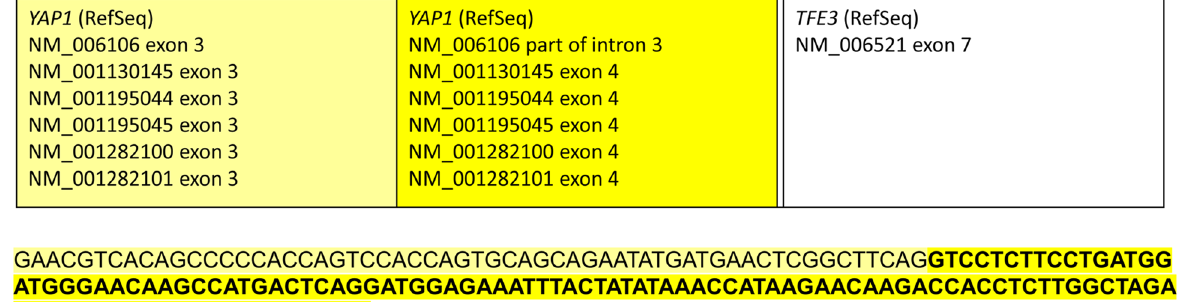
Fig. 2 Breakpoit analysis of the YAP1-TFE3 fusion RNA sequencing analysis revealed 265 bases long sequence (identified in 242 the fusion sequence is provided in the lower part of the figure). Verified breakpoints are indicated by double line and correspond to YAP1 breakpoint (GRCh37) chr11:102,056,862 and TFE3 breakpoint (GRCh37) chrX:48,891,297. According to the main RefSeq reference sequence NM_006106, the final fusion transcript includes exonisation of a part of YAP1 intron 3, which corresponds to YAP1 exon 4 according to other alternative transcripts (e.g. NM_001130145), followed by exon 7 of TFE3 (NM_006521). The upper part of the figure shows a diagram of the sequence